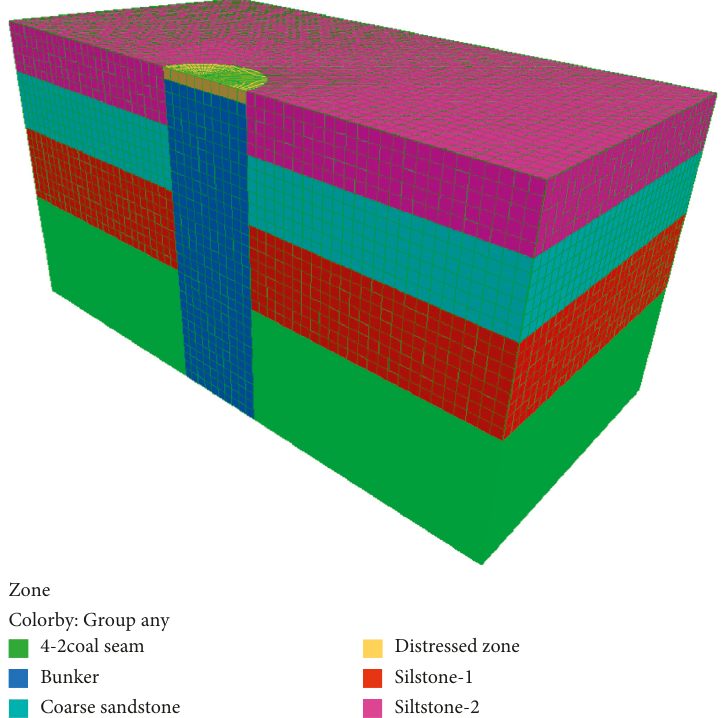
Figure 11: FLAC3D model of coal bunker #3.